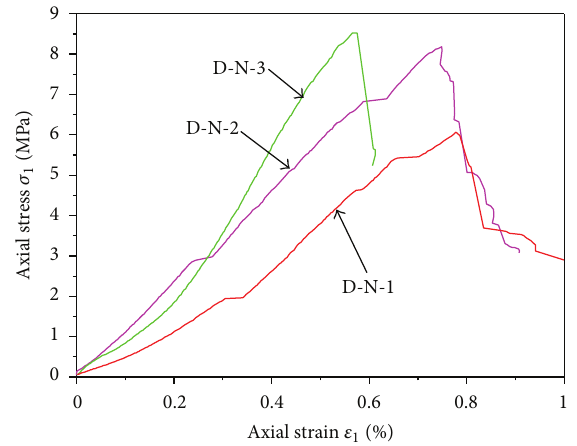
Figure 5: Stress-strain relations of coal samples under uniaxial